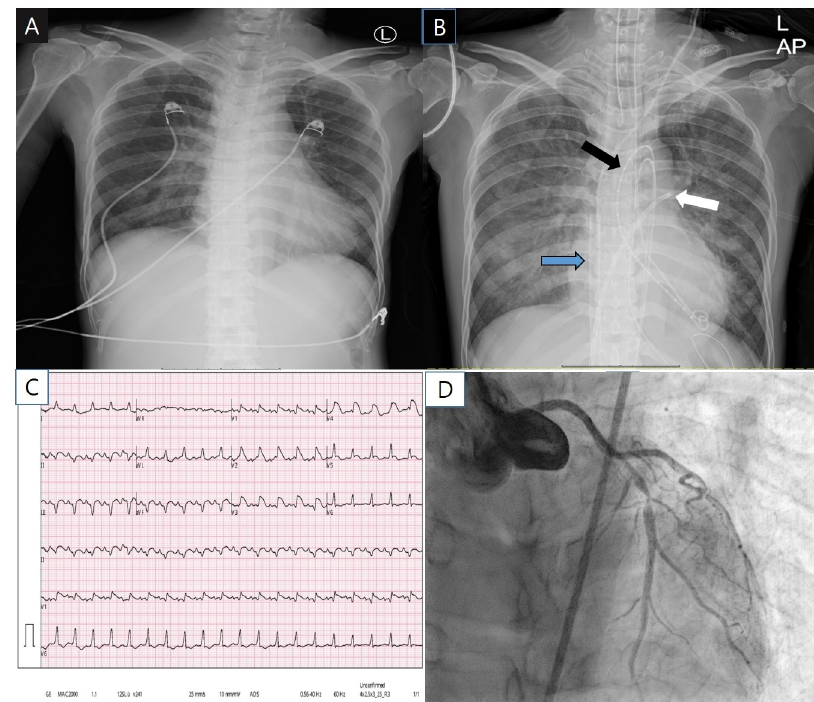
Figure 1. The patient’s chest X-ray ( A , B ), electrocardiogram ( C ) and coronary angiography ( D ). Black arrow, trans-aortic LV venting catheters; white arrow, transseptal left atrium venting catheter; Blue arrow, venous drainage catheter of extracorporeal oxygenation support.